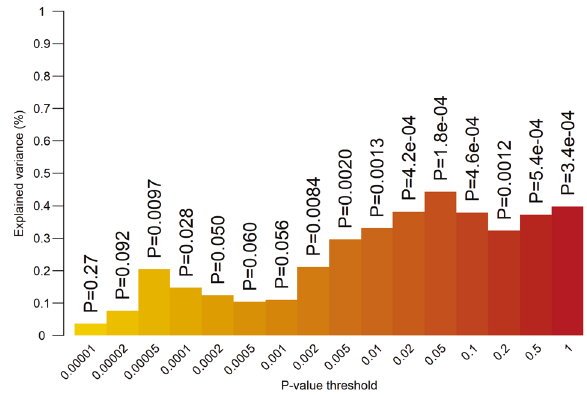
Fig. 2 Proportion of explained variance (vertical axis) in child- hood aggression at age 7 by polygenic scores from the overall GWAMA for multiple P value thresholds (horizontal axis). Numbers above the bars represent unadjusted P values for two- sided test of signi fi cance.